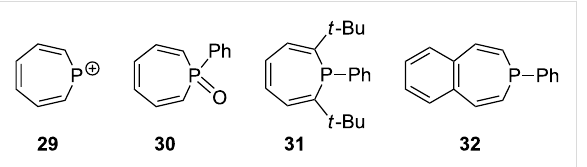
Figure 4: Reported phosphepines 29 – 32 .